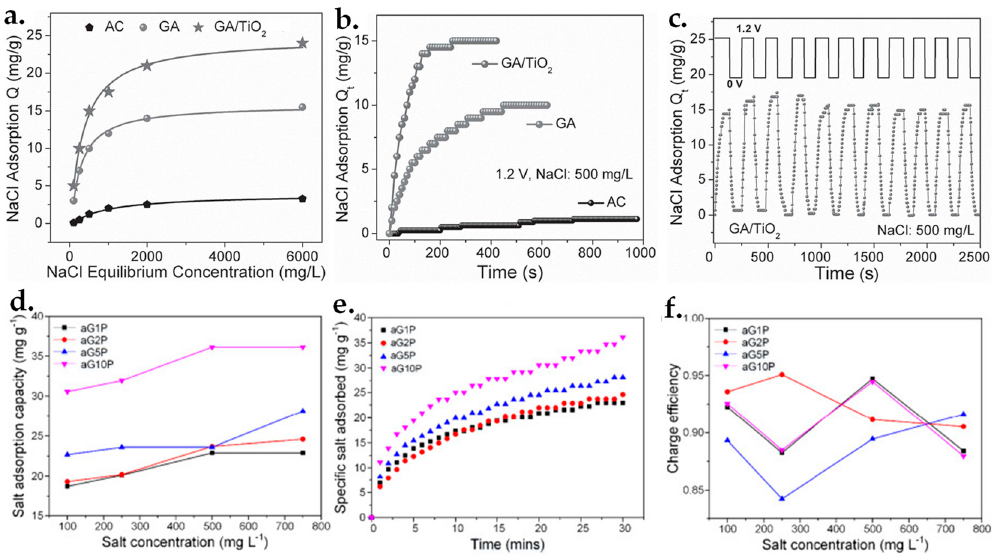
Figure 9. Desalination performances of three-dimensional (3D) GA/TiO 2 hybrids and graphene oxide (GO)-polyvinyl alcohol (PVA) composites as CDI and M-CDI electrode materials: ( a ) Salt adsorption capacity of activated carbon (AC), graphene aerogel (GA) and GA/TiO 2 . ( b ) Time dependent desalination behaviors of AC, GA and GA/TiO 2 . ( c ) Desalination and regeneration cycles of GA/TiO 2 . ( a – c ) were reproduced from [211], with permission from Wiley, 2013. ( d ) Salt adsorption capacity as functions of salt concentration for four different GO:PVA ratios (G n P, n = 1,2,5 or 10). ( e ) Specific salt adsorption at a NaCl concentration of 750 ppm. ( f ) Dependent of charge efficiency on different salt concentrations. ( d – f ) were reproduced from [217], with permission from Elsevier, 2019.